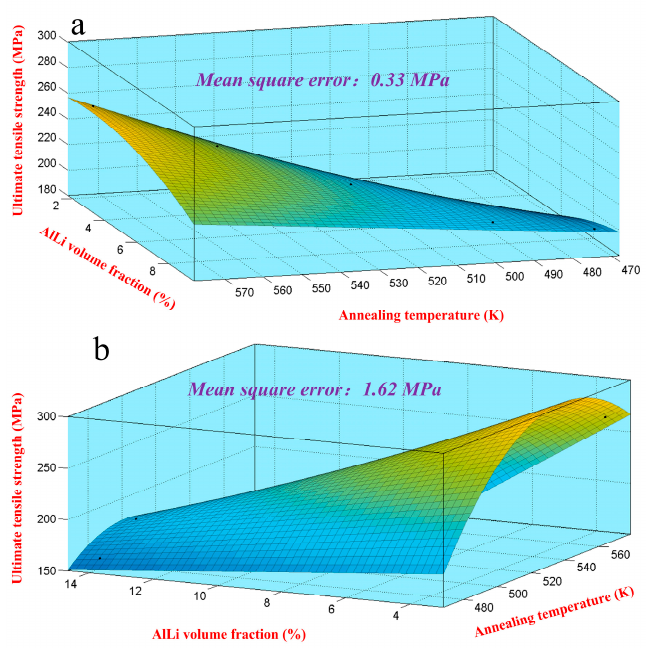
Figure 13. Fitting map of ultimate tensile strength under different volume fractions and temperatures: ( a ) Mg-8Li-3Al-2Zn-0.2Y; ( b ) Mg-11Li-3Al-2Zn-0.2Y.